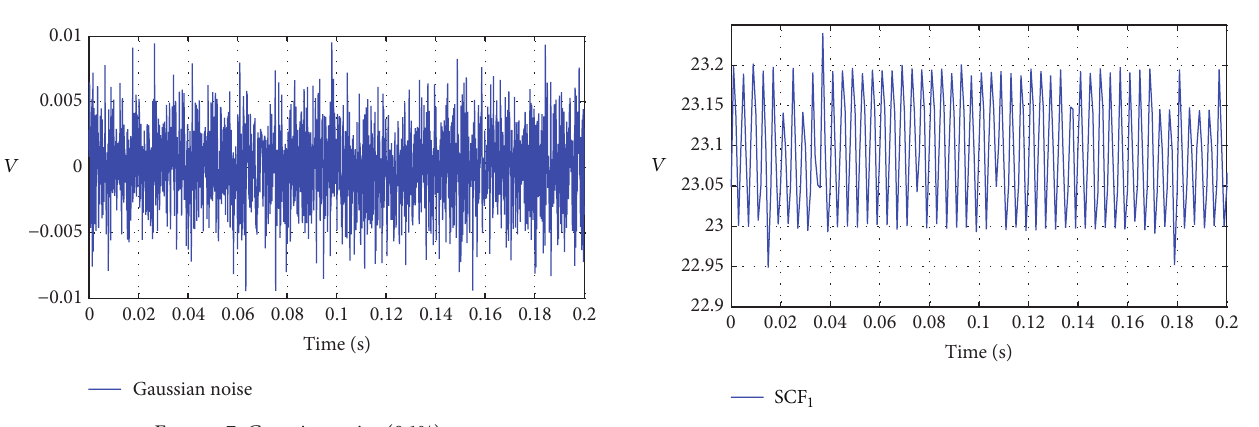
Figure 8: Voltage signal of SCF 1 with Gaussian